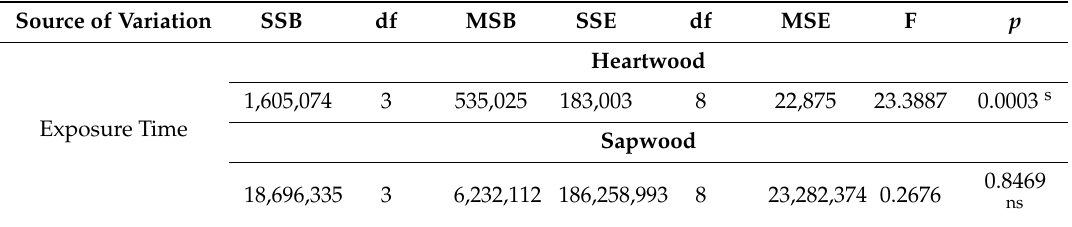
Table 2. Analysis of variation (ANOVA) for TVOC concentrations obtained for the heartwood and sapwood of the studied species in the same exposure